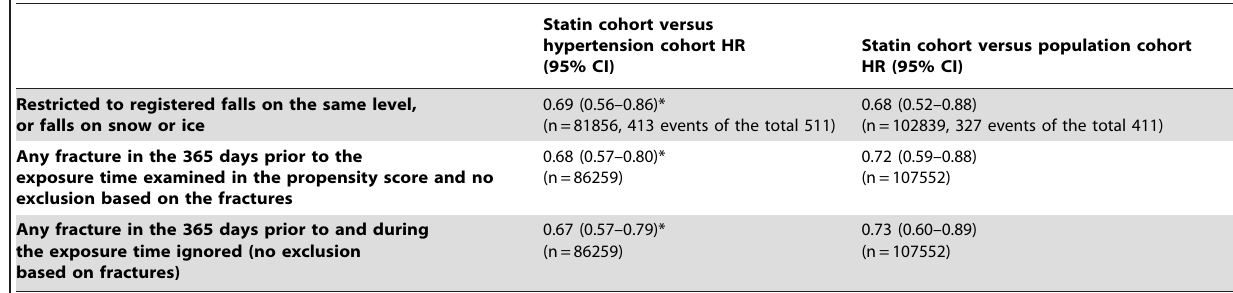
Table 5. Subgroup